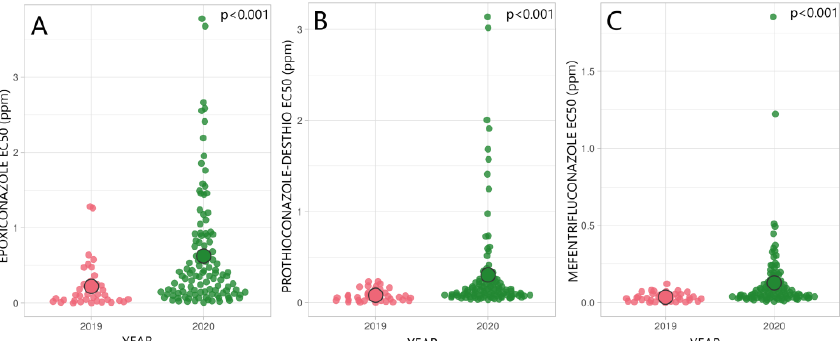
Figure 2. Sensitivity of R. collo-cygni population in 2019 and 2020 in Estonia to DMI fungicides epoxiconazole ( A ), prothioconazole-desthio ( B ), and mefentrifluconazole ( C ). ○ indicates average EC 50 value (ppm) in a population; p < 0.001 shows a significant difference between the years according to the unpaired t -test with Welch’s correction.